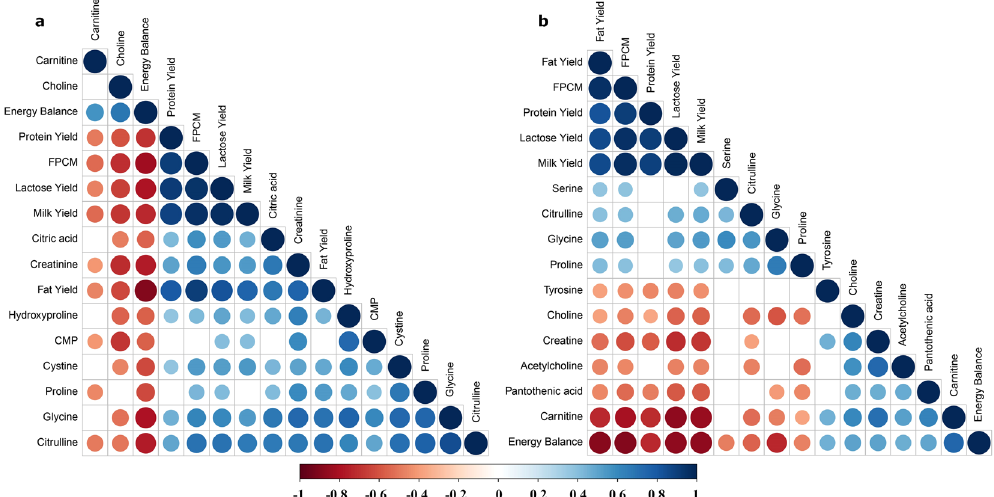
Figure 3. Pearson correlations matrix between 15 variables in milk with the relatively higher variable importance in projection score from partial least squares analysis and energy balance of dairy cows in lactation week 2 ( a ) and week 7 ( b ). The size of dots is proportional to the absolute value of correlations, the blue and red colour represent positive and negative direction of correlations, respectively, and blank represents that there was no correlation between two variables ( P -value > 0.05). Abbreviations: CMP, cytidine monophosphate; FPCM, fat- and protein-corrected